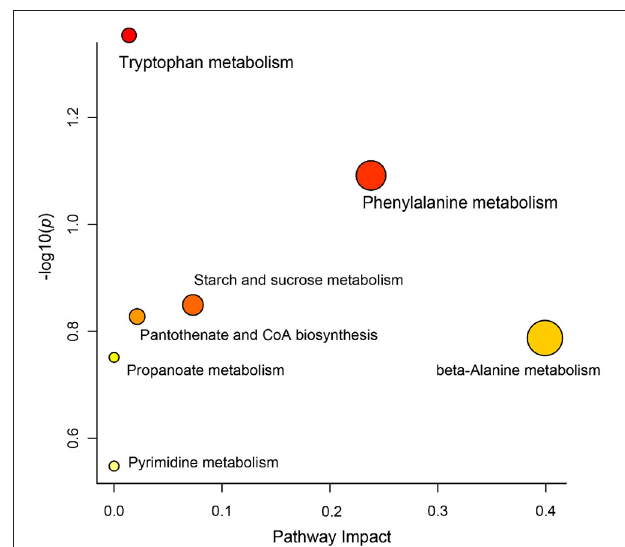
FIGURE 5 | KEGG pathways based on the differential metabolites identified in different